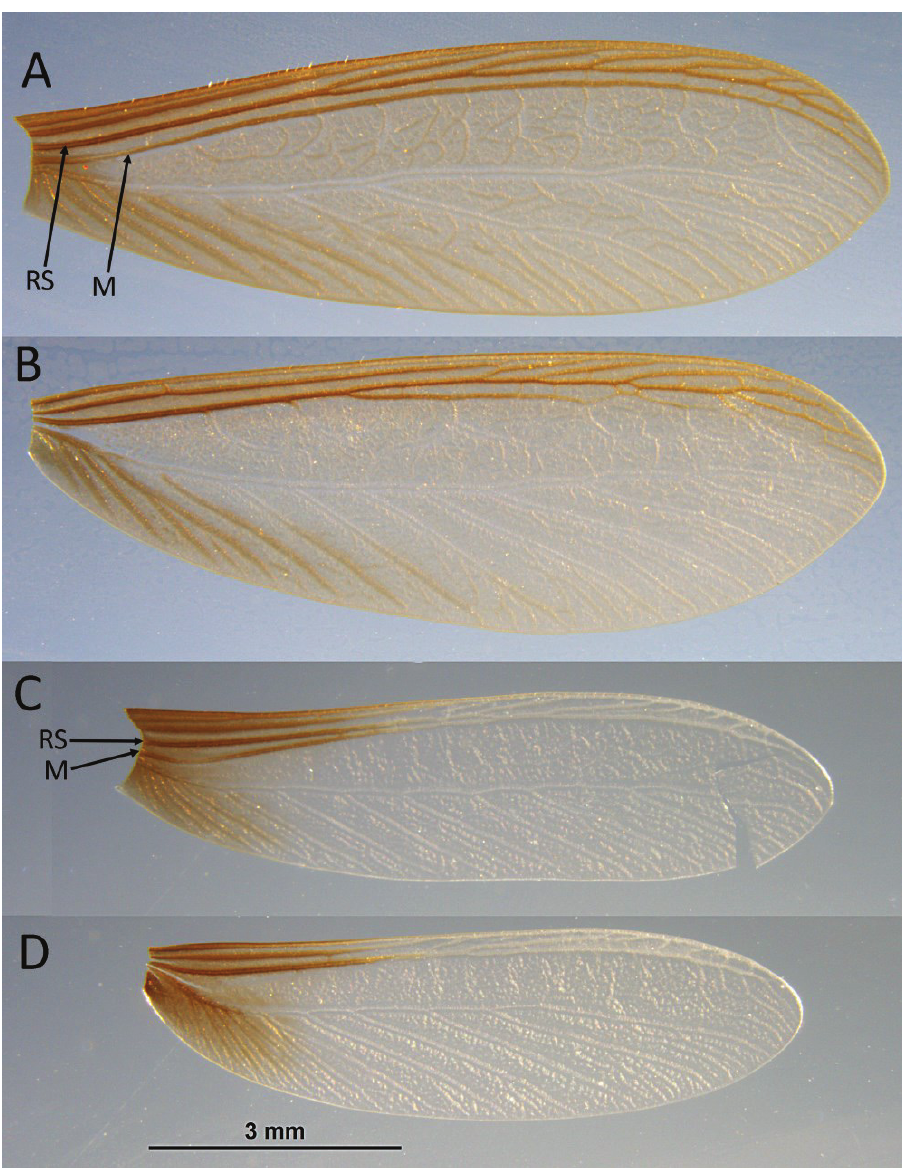
Figure 3. Neotermes aburiensis forewing ( A ) and hind wing ( B ). Neotermes agilis fore wing ( C ) and hind wing ( D ). RS = radial sector, M = median